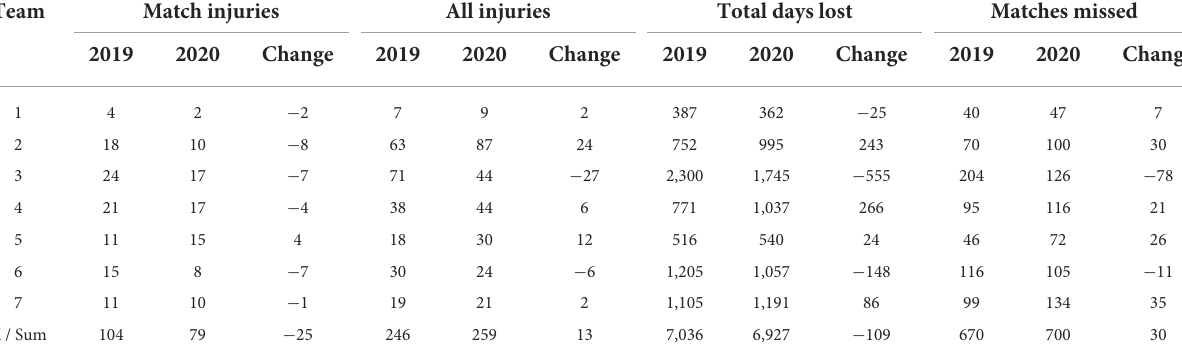
TABLE 2 Number of match injuries, all injuries, total days lost due to injury and matches missed for the 2019 and the 2020 seasons.